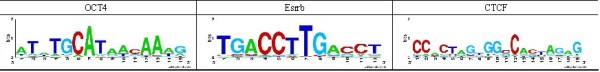
Alternative motifs for OCT4, Esrrb, and CTCF. This figure shows alterative motifs predicted by TFBSGroup for TFs OCT4, Esrrb and CTCF.